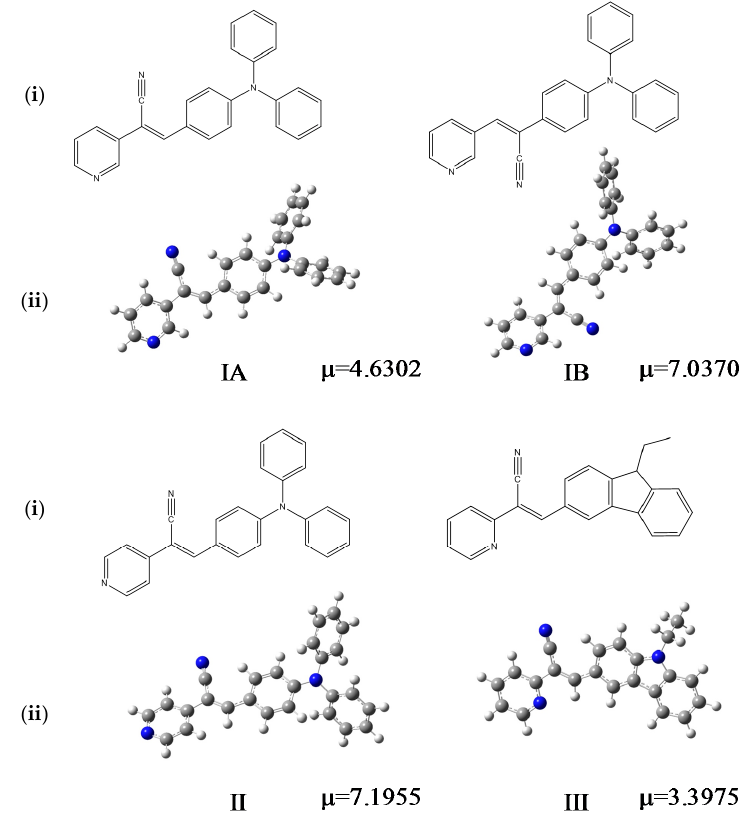
Figure 1. Chemical formulas of the compounds performed in ChemDraw software ( i ), optimized structures and µ (dipole moment, Debyes) calculated in gas phase at M06L/cc-pVDZ theory level ( ii ).